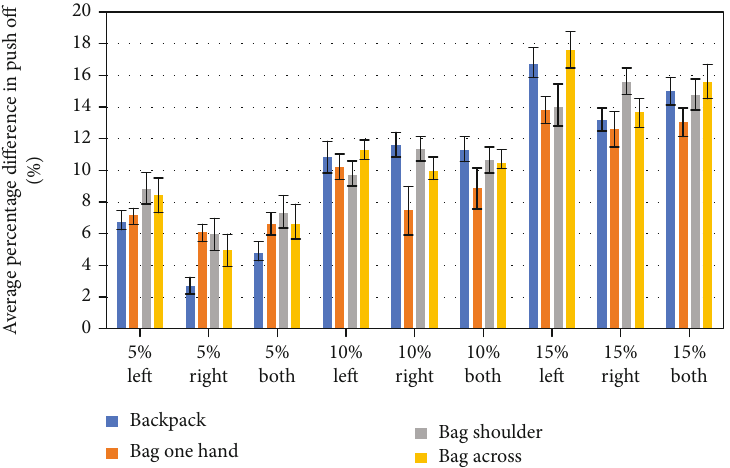
Figure 8: Push-o ff forces for the left, right, and average of both (left and right side) for di ff erent levels of additional